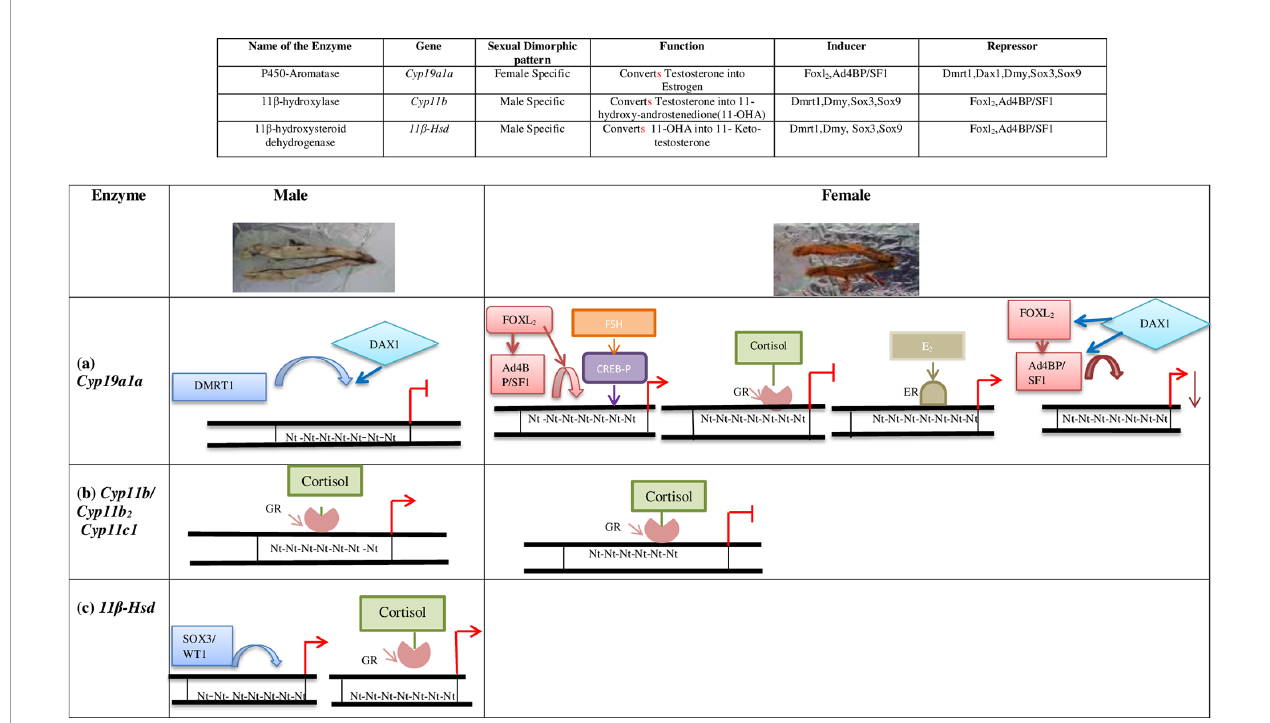
FIGURE 1 | Sex speci fi c regulation of gonadal steroidogenesis by transcription factors. Images of testis and ovary are representatives of a typical fresh water teleost ( Schizothorax plagiostomus, Order: Cypriniformes, Family: Cyprinidae ). (A) Regulation of Cyp19a1a promoter: In testis, DMRT1 alone or in synergy with DAX1 represses the Cyp19a1a transcription. In ovaries, FOXL 2 either alone or along with Ad4BP/SF-1 activates Cyp19a1a transcription. CREB-P upregulates the transcription of Cyp19a1a in synergy with FOXL 2 and Ad4BP/SF1 under the in fl uence of FSH. Cortisol induced Glucocorticoid Receptor (GR) blocks the aromatase enzyme. Estrogen bound Estrogen Receptor (ER) acts as a potential inducer of Cyp19a1a transcription. DAX1 negatively regulates the Cyp19a1a expression by suppressing Ad4BP/SF-1 and FOXL 2 (B) Regulation of Cyp11b/Cyp11b 2 /Cyp11c1 promoters: Cortisol induced GR activates the transcription of Cyp11b/Cyp11b 2 / Cyp11c1 in males. (C) Regulation of 11 b - Hsd promoter: In males, SOX3/WT1 binds to 11 b -Hsd and promoters its transcription and Cortisol induced GR activates the transcription of 11 b -Hsd. : Repression : Activation : Decline in activity, Nt, Nucleotide